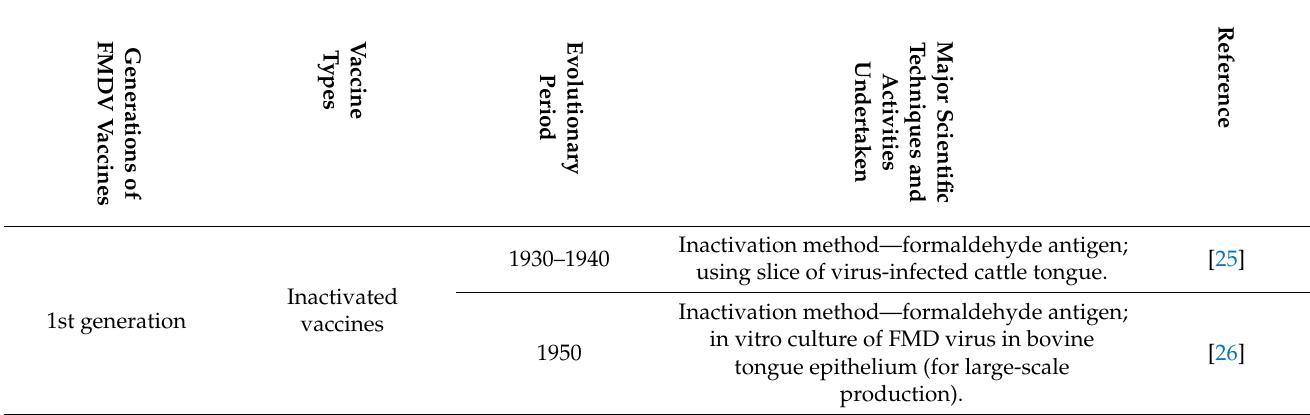
Table 2. Different types and generations of FMDV vaccines and their evolutionary